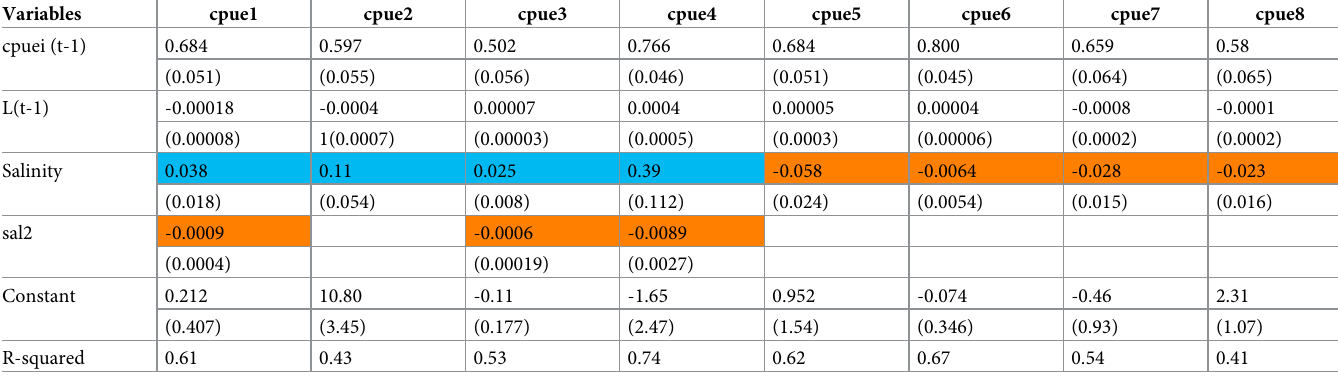
Table 3. Effect of salinity on catch